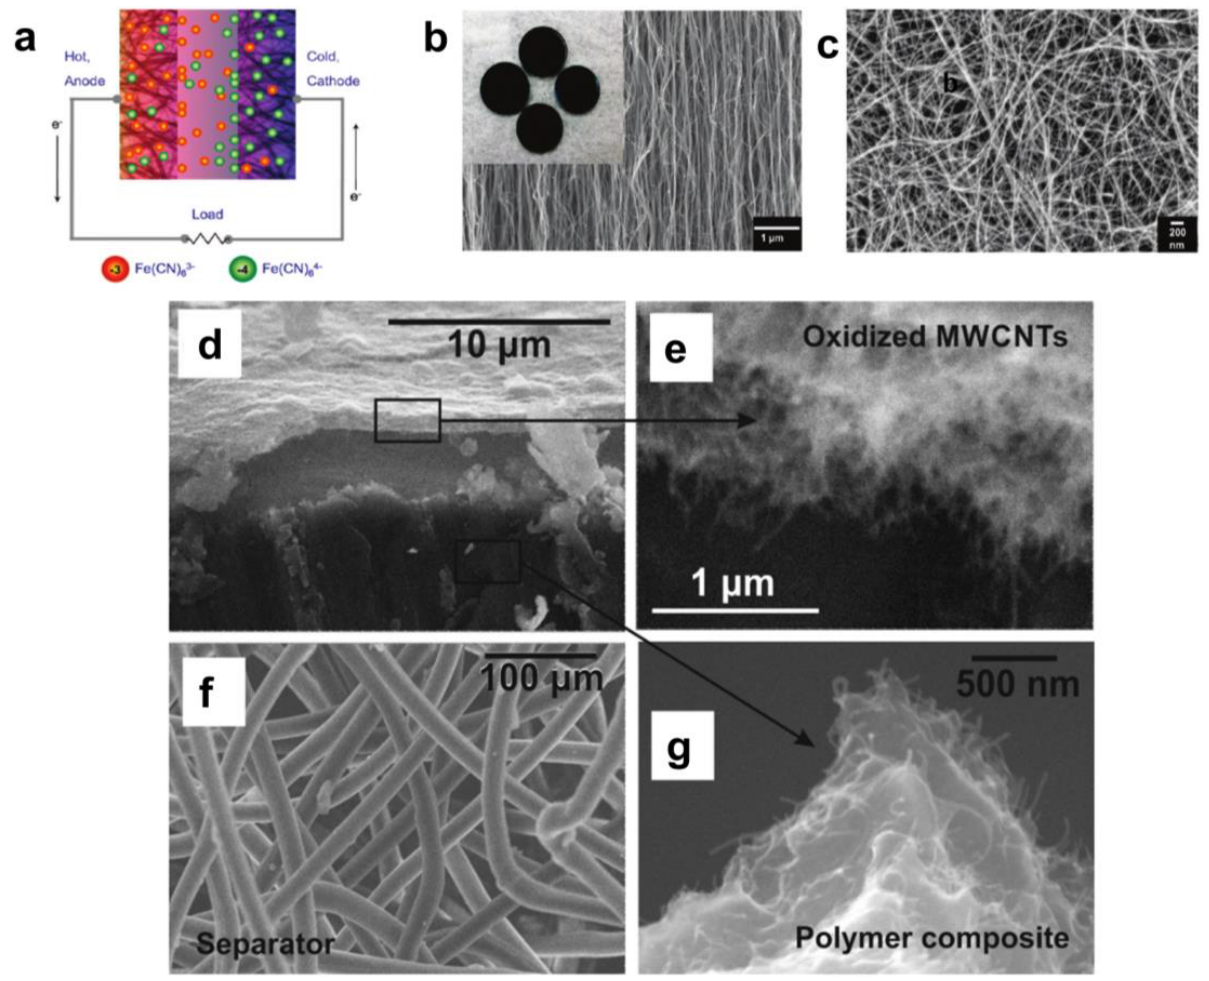
Figure 5. ( a ) Schematic of a thermocell with nanostructured electrodes showing concentration gradients of the ferri-ferrocyanide redox ions during power generation. ( b ) SEM micrograph of vertical MWNT forest. The average MWNT diameter is approximately 20 nm. The inset shows coinlike stainless steel substrates fully coated with vertical MWNTs. Each substrate has a diameter of 2 cm. ( c ) SEM micrograph of MWNT buckypaper. The average MWNT diameter is 10 nm. TEC response in 0.1 M equimolar solution of K 3 Fe(CN) 6 /K 4 Fe(CN) 6 . (Reproduced with permission from [98]. Copyright 2010 American Chemical Society). SEM image of components of the cell: ( d ) electrode structure; ( e ) cover oxidized MWCNTs layer; ( f ) separator; ( g ) fracture of polymer nanocomposite. (Reproduced with permission from [99]. Copyright 2019 IOP Conf. Ser.). Due to the restricted ion migration, gel cells have high intrinsic impedance and low short-circuit current density, which leads to low output power density. Therefore, the practical application of thermoelectric chemical cells is greatly limited. H et al.